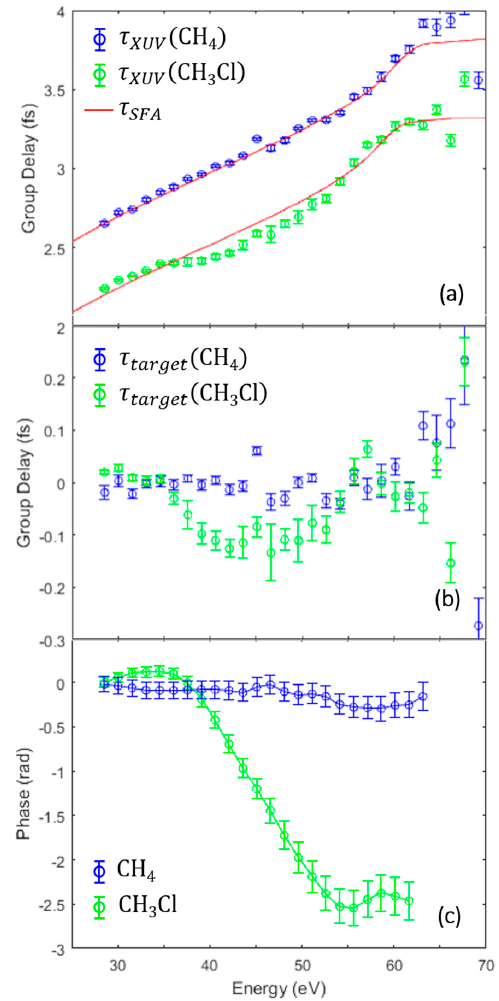
Figure 4. Methane and methyl chloride comparison. Methane (blue) and methyl chloride (green) group delays are shown with the filter and atomic delays removed. ( a ) The strong-field approximation (SFA) group delay (red) is shown along with the high-harmonic contribution ( τ HHG ) from the experiment. The SFA intensity was fit using methane, resulting in an intensity of 5.56 × 10 13 W/cm 2 , and then, this same intensity was applied to the methyl chloride data. The methyl chloride data are shown with a − 0.2-fs shift for visual clarity. ( b ) After removal of the SFA curve, τ target was isolated. By doing so, the CM in methyl chloride was revealed as a ~120-as structure in group delay. ( c ) Group delays were then integrated to show the phase shift of approximately 2.6 radians across the CM. With only the contribution from the angle-integrated RDME remaining, we integrated the delay- corrected GD to retrieve the phase variation across the interaction up to an arbitrary shift. Overall, we found a variation of approximately 2.6 radians across ~15 eV, shown in Figure 4c, consistent with previous calculations for argon [13,33,34], in which the coupled time-dependent Schrödinger equation and Maxwell’s wave equations were solved [35,36] using an angular momentum-dependent